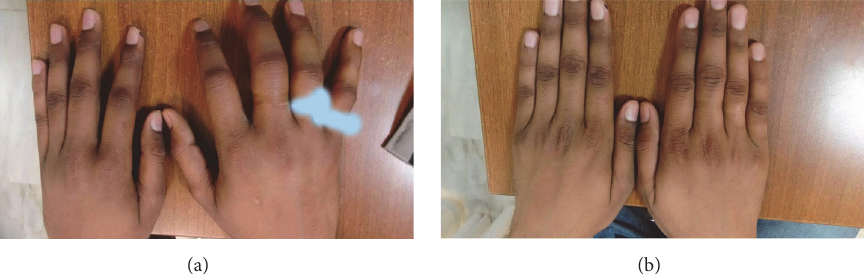
Figure 1: (a) Diffuse swelling of the right hand, more so around the joints. Similar features with lesser severity seen on left hand. His rings (masked by white colour) on the fourth and fifth fingers of the right hand got stuck due to swelling. (b) Complete normalization of swelling after two months of treatment.